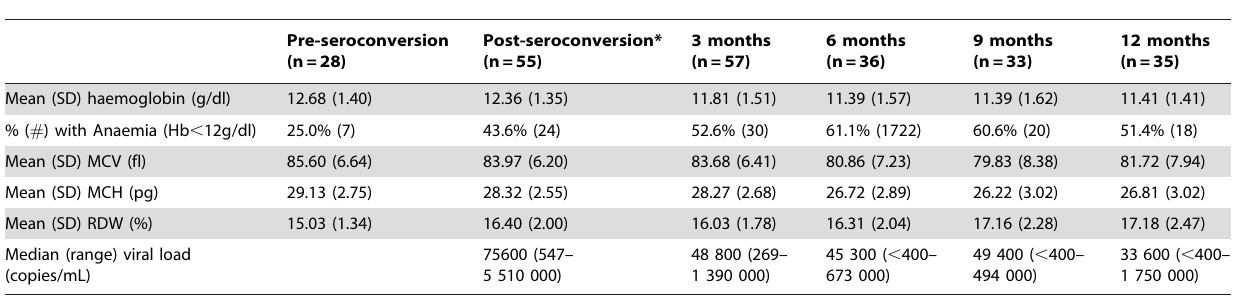
Table 1. Haematologic parameters and median viral load prior to infection and by post-infection month.